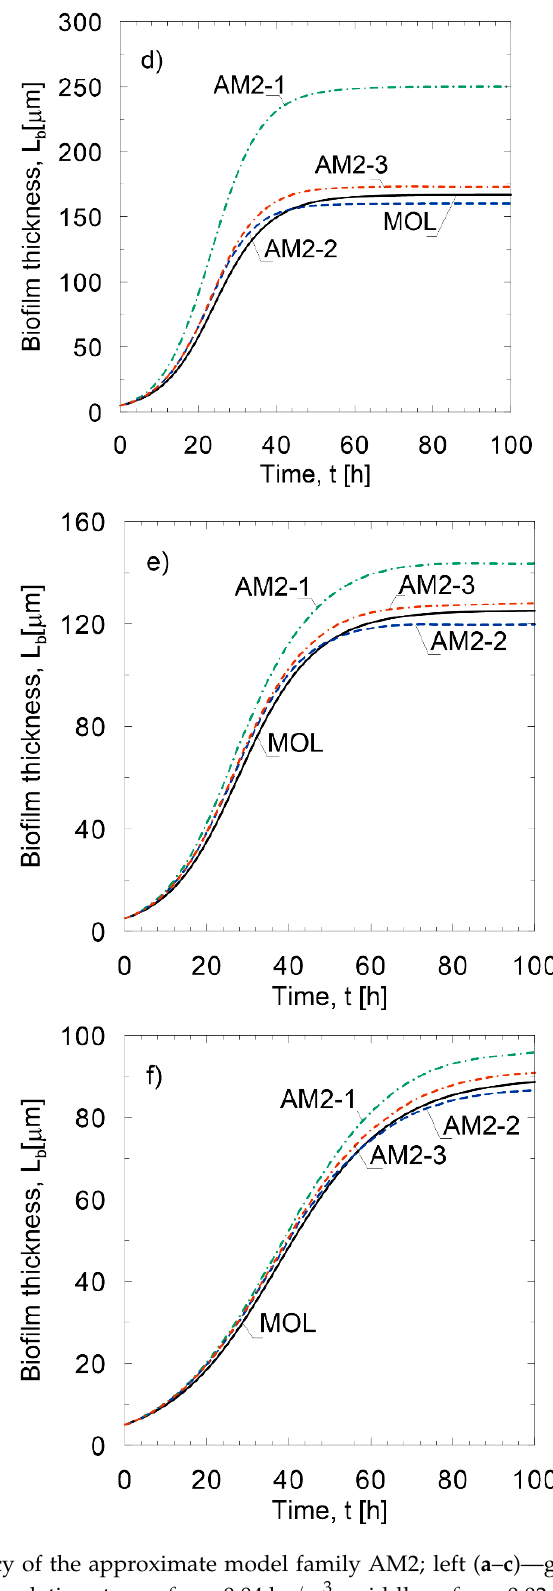
“ 0.04 kg { m 3 ; middle— c c “ 0.02 kg { m 3 ; A A